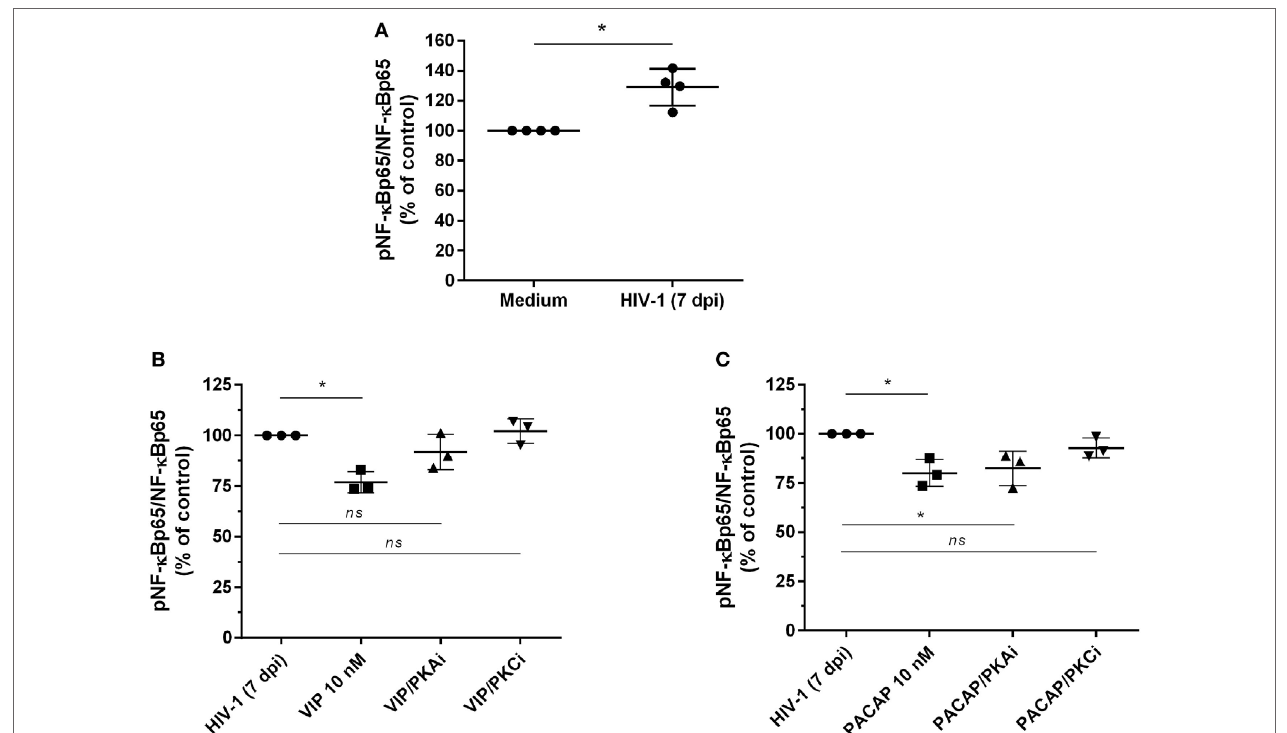
FigUre 4 | Vasoactive intestinal peptide (VIP) and pituitary adenylate cyclase-activating polypeptide (PACAP) inhibit NF-kBp65 phosphorylation in HIV-1-infected macrophages. (a) Macrophages were infected with HIV-1 and 7 days later the levels of NF-kBp65/phosphoNF-kBp65 were analyzed by ELISA ( n = 4). (B,c) Macrophages were treated with VIP or PACAP (10 nM) 7 days after HIV-1 infection (7 dpi), in the presence or not of protein kinases A (PKA) or C (PKC) inhibitors (PKAi, H89; PKCi, Gö 6983; 50 nM each one, for 30 min; cells were washed before neuropeptide addition). After 1 h, the levels of NF-kBp65/phosphoNF-kBp65 were analyzed by ELISA ( n = 3). * p < 0.05; one-way ANOVA, with Dunnett